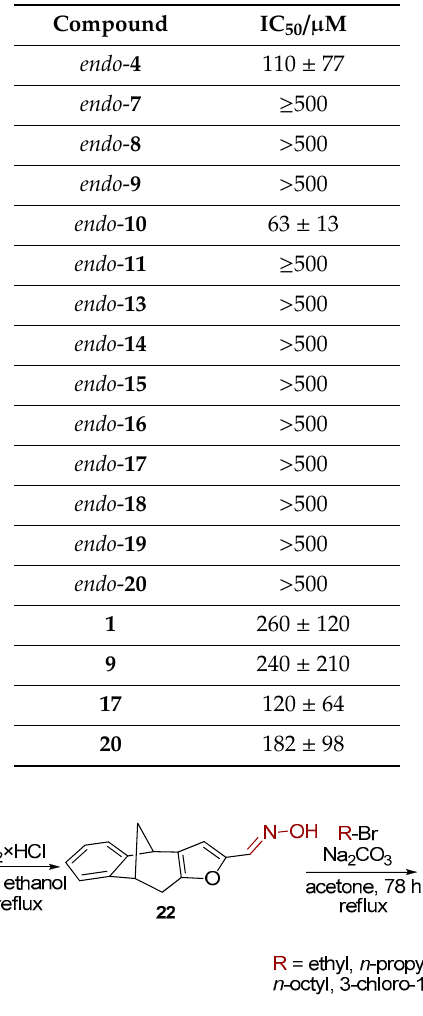
Table 1. Inhibition of BChE by benzobicyclo[3.2.1]octadiene benzylamines expressed as IC 50 ± SEM.